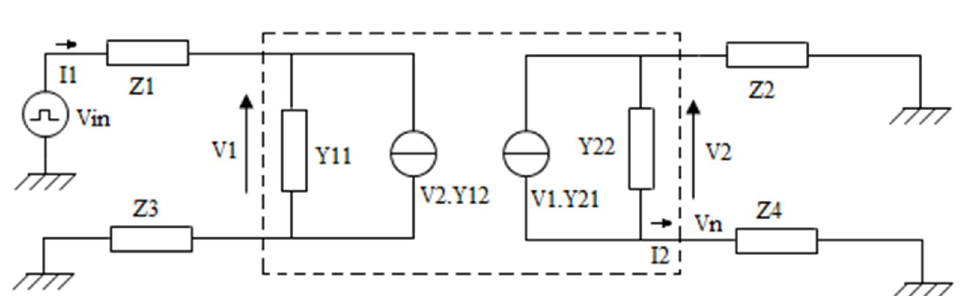
Figure 6. The equivalent circuit model of TSV noise coupling with redistribution layers (RDLs).